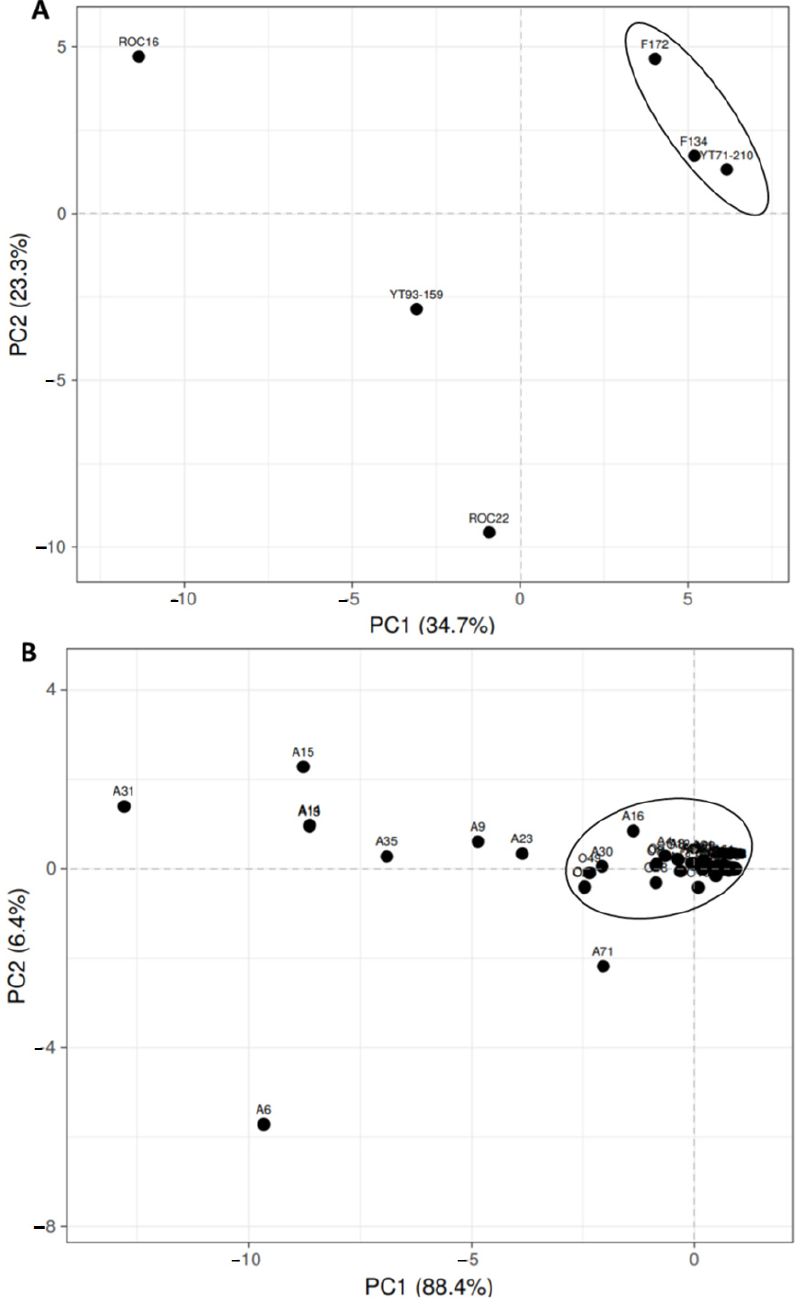
Figure 2. Principal component analysis (PCA) of compounds in six sugarcane varieties. ( A ) Variety-wise scattered PCA, ( B ) individual organic- and amino acid compounds-wise scattered PCA. Here, A means amino acid and O means organic acid compounds and A1–A72 represent the 72 amino acids whereas O1–O55 represent the 55 organic acid compounds; this numbering system corresponds to the serial numbers in Table